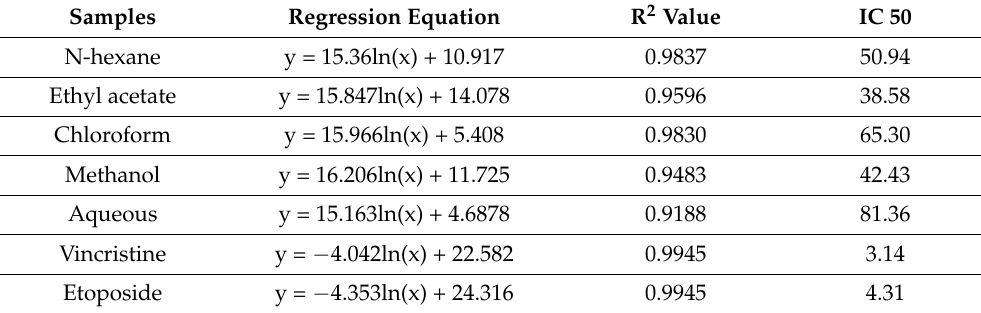
Table 2. Antitumor activiy IC 50 and R 2 values determined through logarthmic regression analysis.